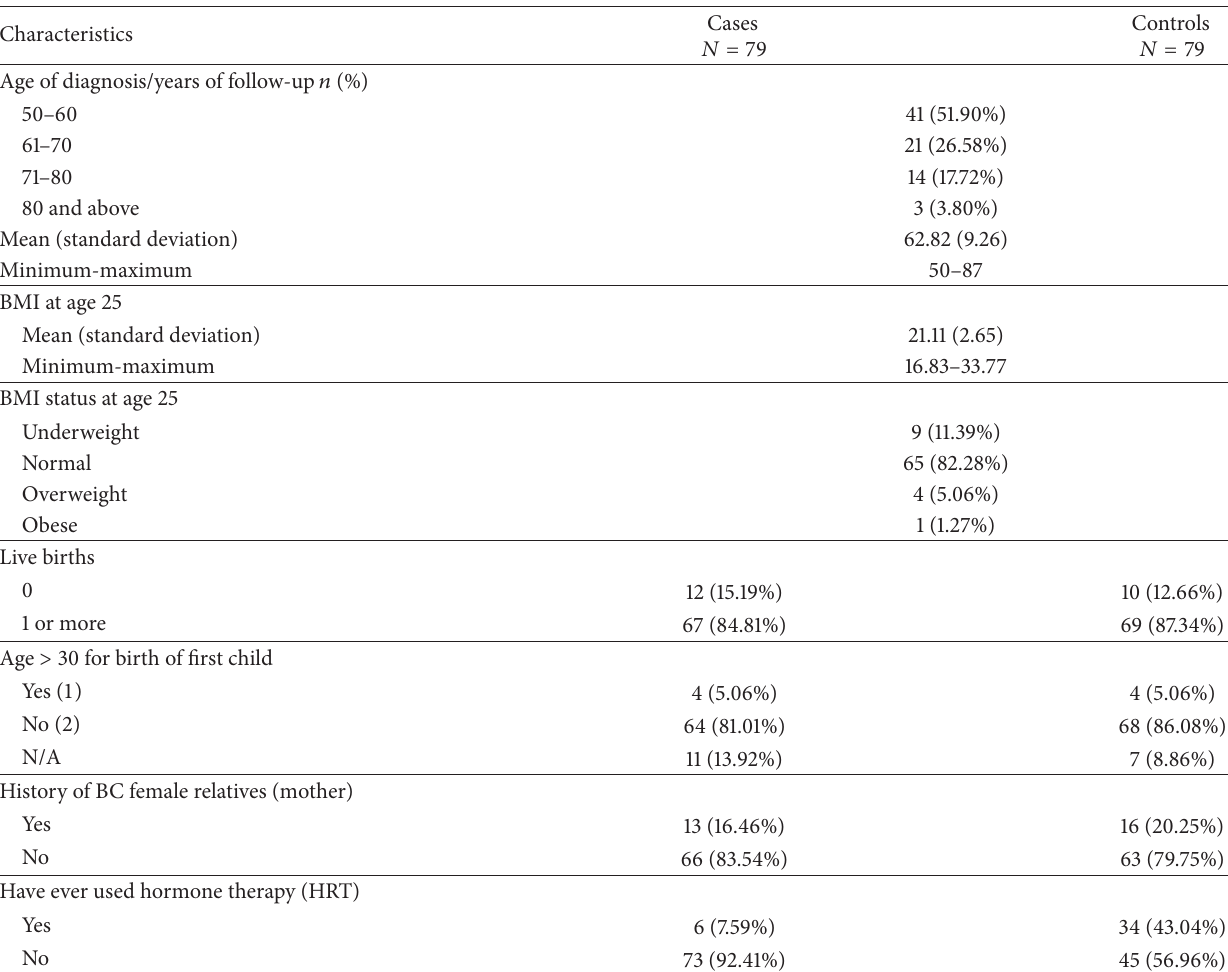
Table 1: Demographics and baseline